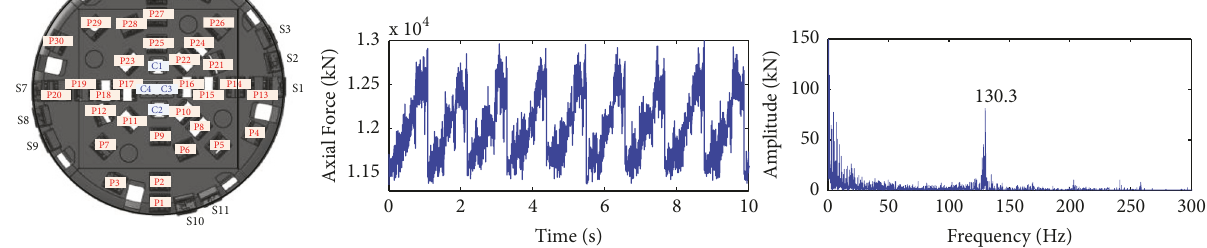
Figure 4: Time-domain curves and frequency spectrum of the simulated loads on TBM cutterhead.